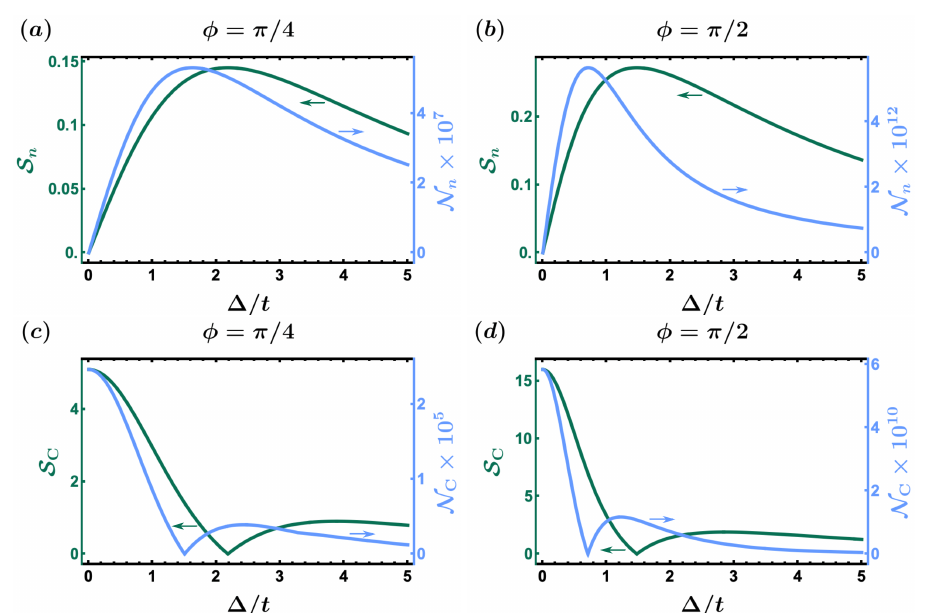
Figure 10: Effect of phase noise. Signal (20) and noise (21) for the 2-MZM measurement of the average QD charge 〈 n / C pacitance C Σ ,D (c)-(d) as a function of detuning diff φ